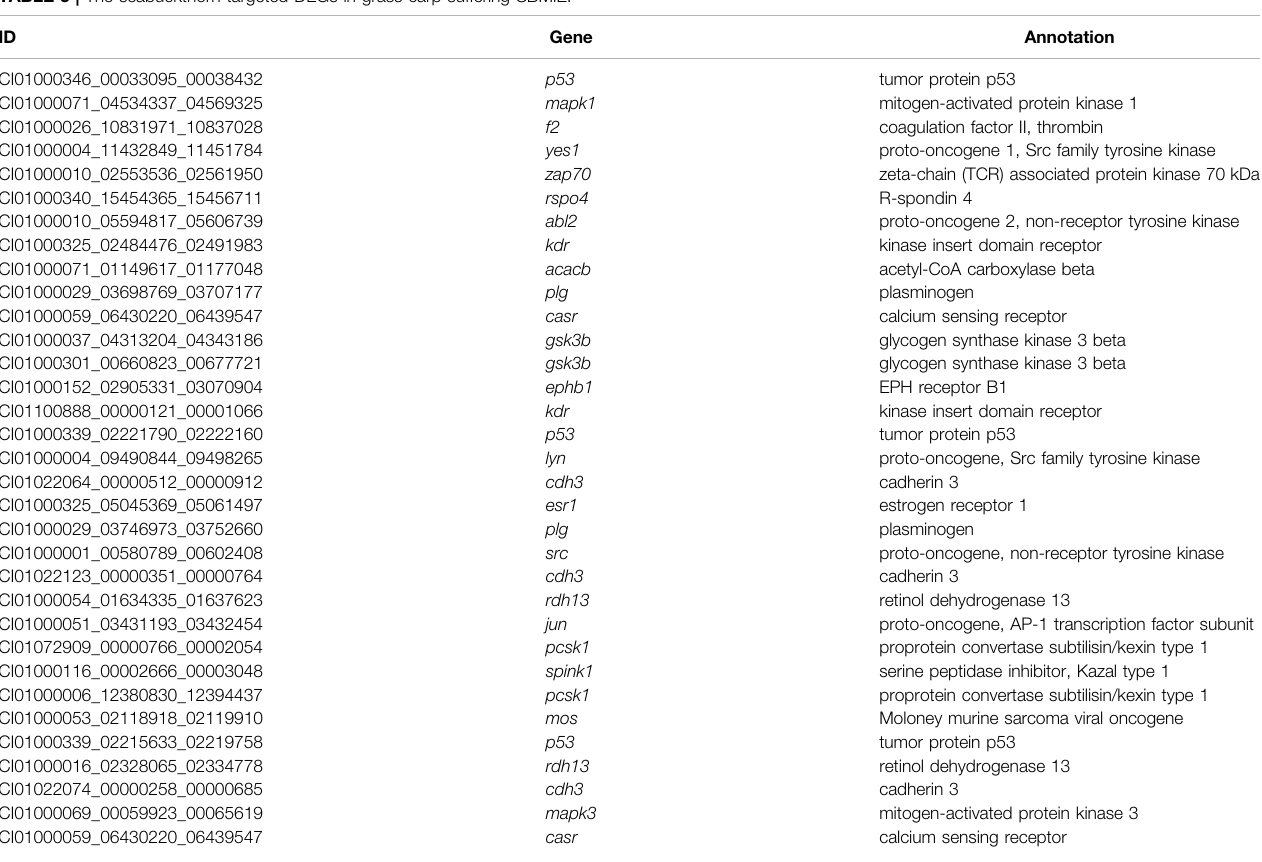
TABLE 3 | The seabuckthorn targeted DEGs in grass carp suffering SBMIE.